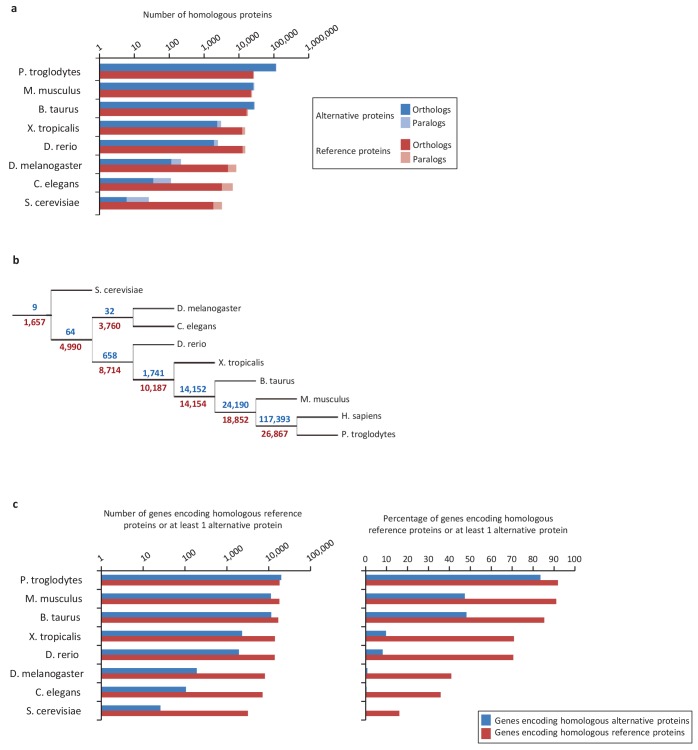
Conservation of alternative and reference proteins across different species.(a) Number of orthologous and paralogous alternative and reference proteins between H. sapiens and other species (pairwise study). (b) Phylogenetic tree: conservation of alternative (blue) and reference (red) proteins across various eukaryotic species. (c) Number and fraction of genes encoding homologous reference proteins or at least one homologous alternative protein between H. sapiens and other species (pairwise study).10.7554/eLife.27860.011Figure 2—source data 1.Conservation of alternative and reference proteins across different species.